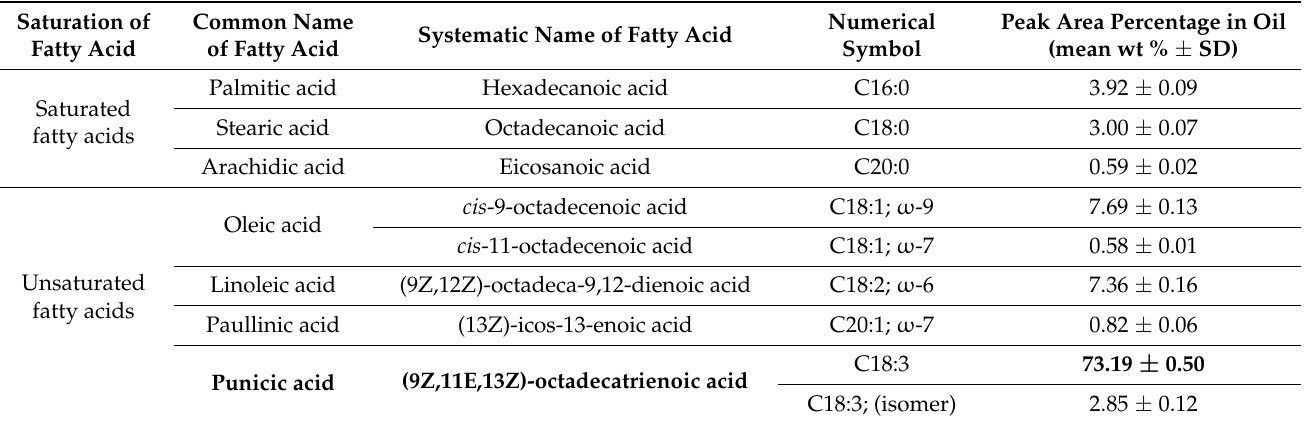
Table 1. Composition of fatty acids of